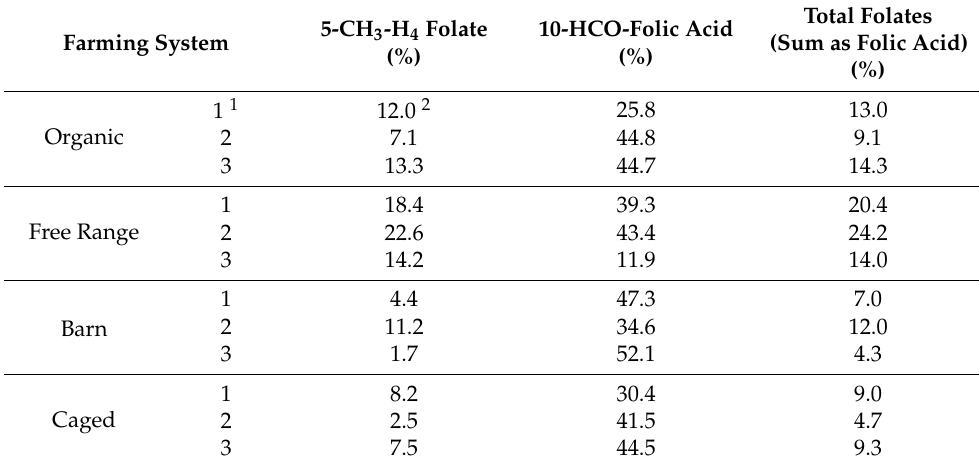
Table 3. Folate losses after cooking (%) in hen eggs from different farming